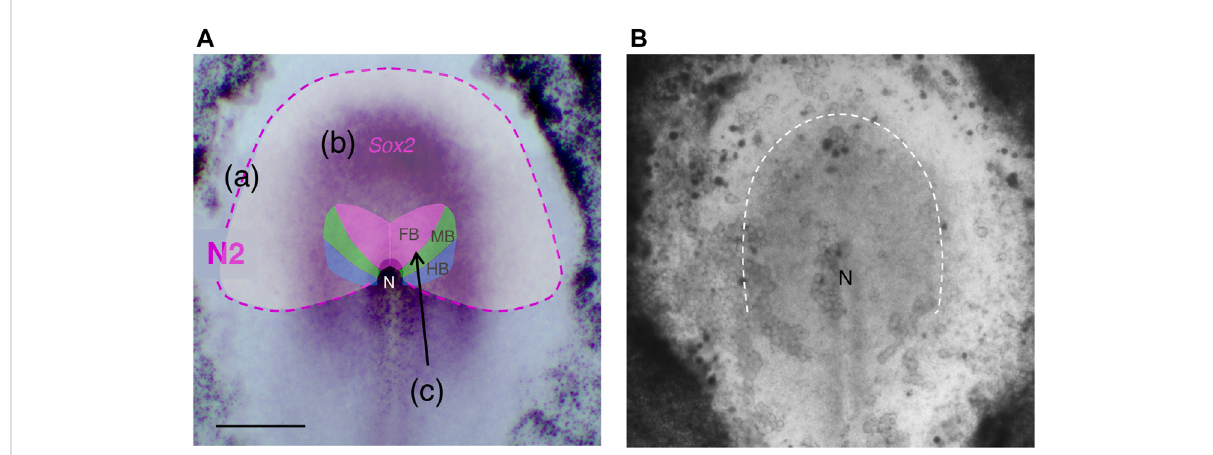
FIGURE 1 Regional characteristics of the anterior epiblast in the st. 5 chicken embryo. (A) Superimposition of the region with N2 enhancer activity, Sox2 expression domain, and the map from Fernández-Garre et al. (2002) of the precursors for the brain portions, the forebrain (FB), midbrain, (MB), and hindbrain (HB). (a) The N2 enhancer activity region is shown in pale white with the outer lining shown as a magenta dashed line. (b) Sox2 expression domain at mid st. 5 is shown by the in situ hybridization signal (purple). (c) The map by Fernández-Garre et al. (2002) drawn using homotopic grafting of labeled epiblast disks of ~100 µm diameter is shown as a reference. The map was drawn for st. 4 embryos. However, the same map holds for early st. 5, as anterior epiblast cell migration is minimal until early st. 5. The brain precursor map was revised as shown in Figure 3 using the trajectoryanalysisofsingle-cellresolutioninourstudy(Yoshihietal.,2022).Theanteriorsideisdirectedupward.N,thenode.Scalebar,500 µm.This panel was adapted from Yoshihi et al. (2022) Supplementary Figure S1. (B) A translucent image of a cultured chicken embryo of the stage analogous to (A) , taken from a frame of Supplementary Movie S1. A cloudy region outlined by the broken line indicates the population of epiblast cells converging to the